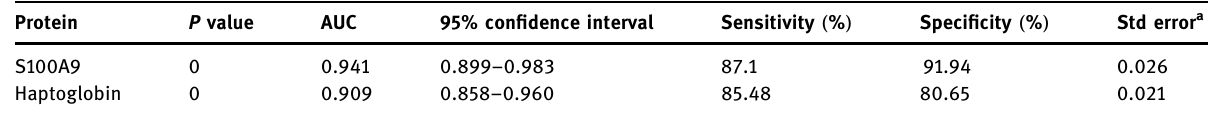
Table 3: The discriminatory power of salivary S100A9 and haptoglobin for the detection of RCC